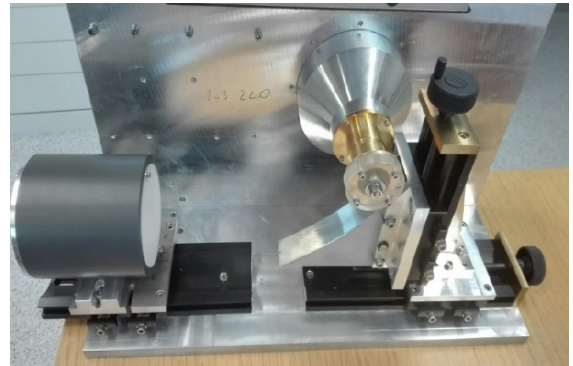
Fig. 6. Mode generator set-up.